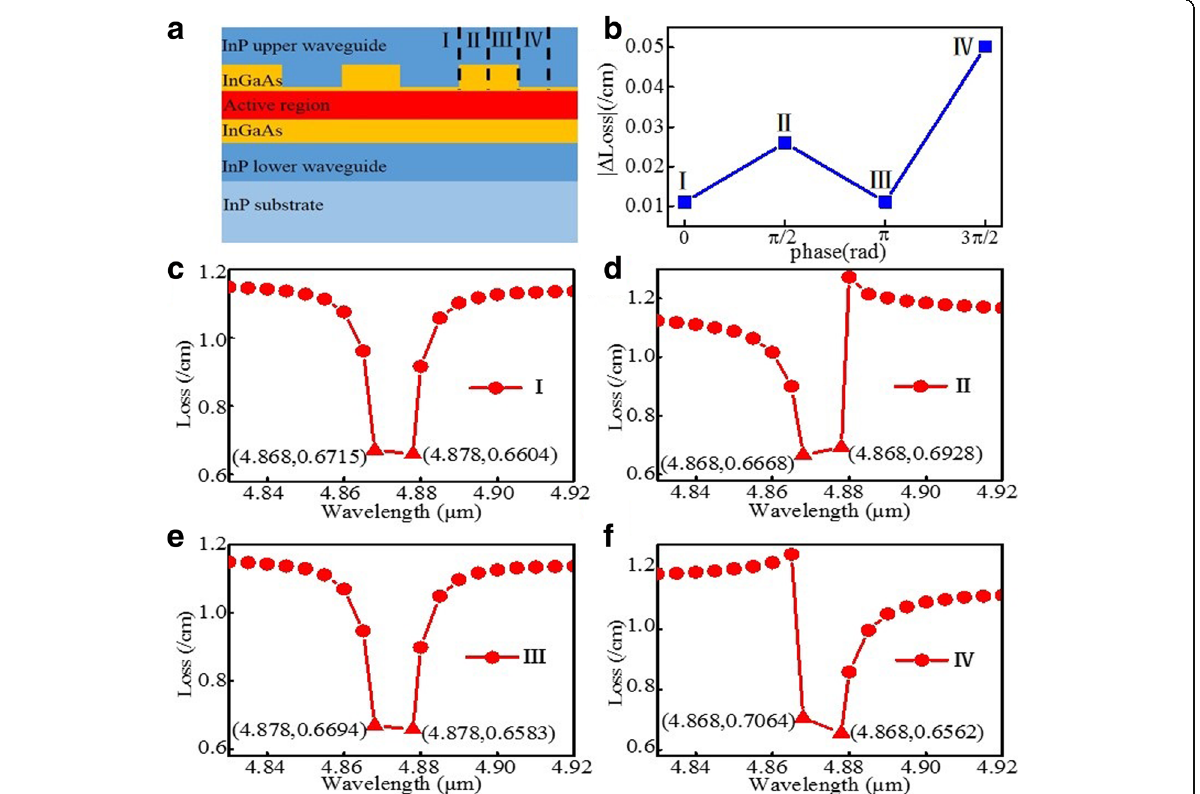
Fig. 1 a The diagram of uniform grating structure; the denotations of I, II, III, and IV represent the possible four kinds of cleaved end facet positions. b The absolute values of mode loss difference for different cleaved end facet positions of I, II, III, and IV, and the abscissa is represented as a corresponding phase of cleaved facet positions of I, II, III, and IV. c – f The spectra of mode losses of the possible four kinds of cleaved end facet positions of I, II, III, and IV,